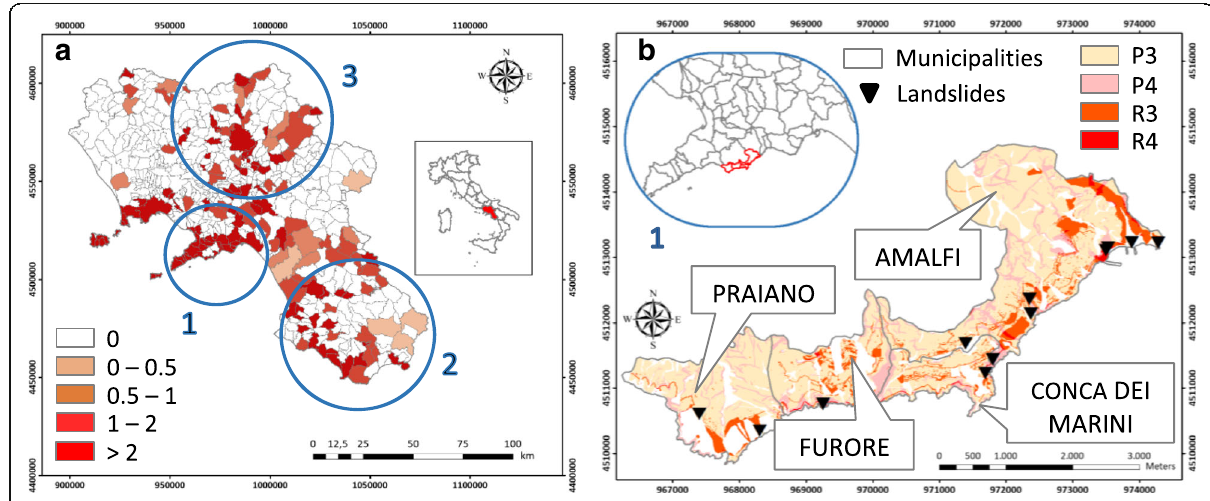
Fig. 11 ( a ) Values of the Landslide Index (LI) in the Campania region, per municipality; ( b ) four municipalities of the Lattari mountains (zone 1 in Figure a ): landslides recorded in the FraneItalia catalog and areas zoned by the river basin Authority at high/very high landslide hazard (P3/P4) or risk